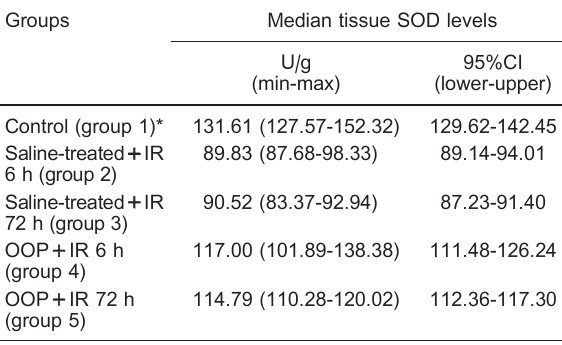
Table 4. Tissue SOD levels of control, saline-treated++IR, or OOP++IR groups decapitated at 6 or 72 h after irradiation.